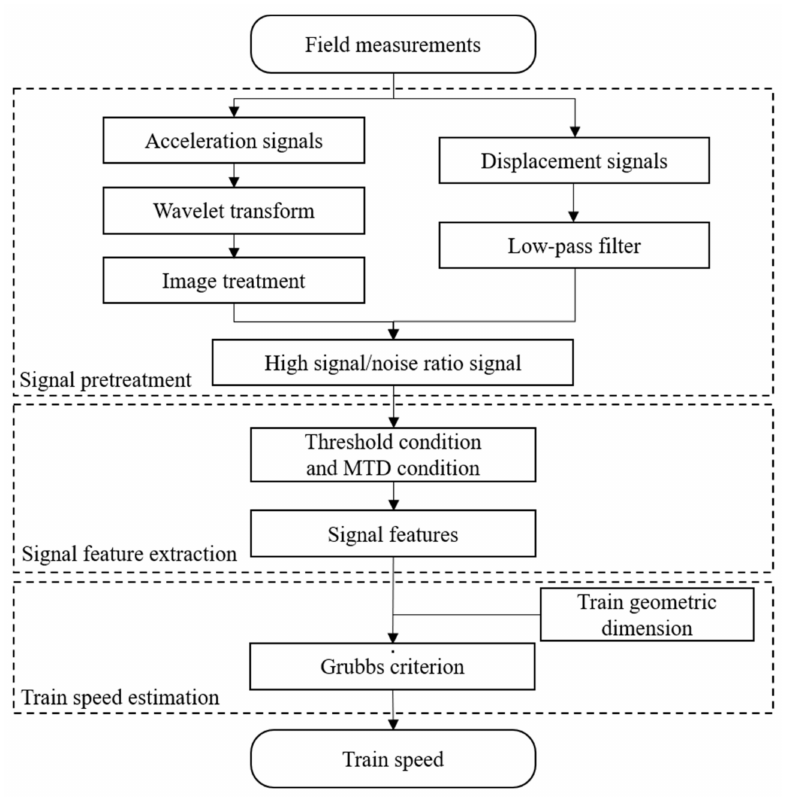
Figure 2. The framework of the proposed train speed estimation